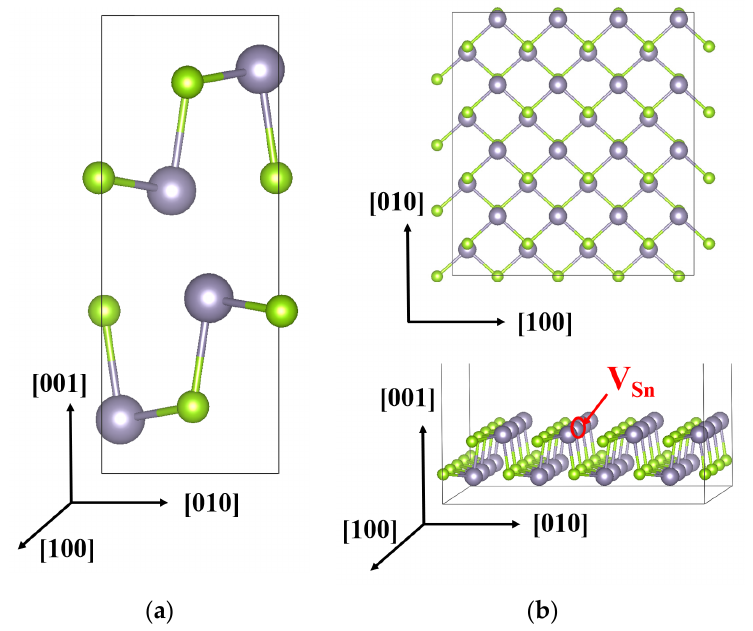
Figure 1. The structure of SnSe. ( a ) Unit cell of bulk SnSe. ( b ) Top view and perspective view of the constructed SnSe supercell. Navy-colored balls represent Sn atoms and green balls represent Se atoms. The red circle indicates an Sn vacancy.